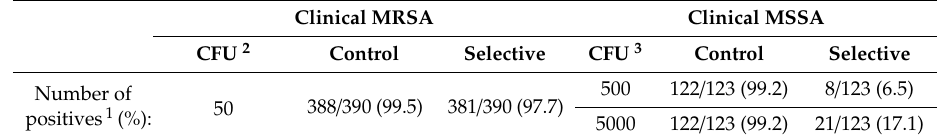
Table 4. Performance of methicillin-resistant Staphylococcus aureus (MRSA) screen with clinical Staphylococcus aureus. Clinical MRSA Clinical MSSA CFU 2 Control Selective CFU 3 Control